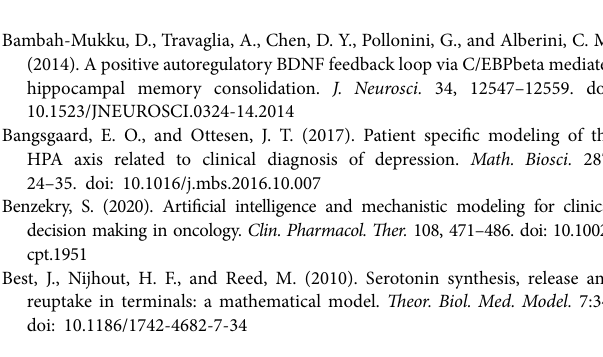
Supplementary Table 1 | The ordinary differential equations and basal values of the model